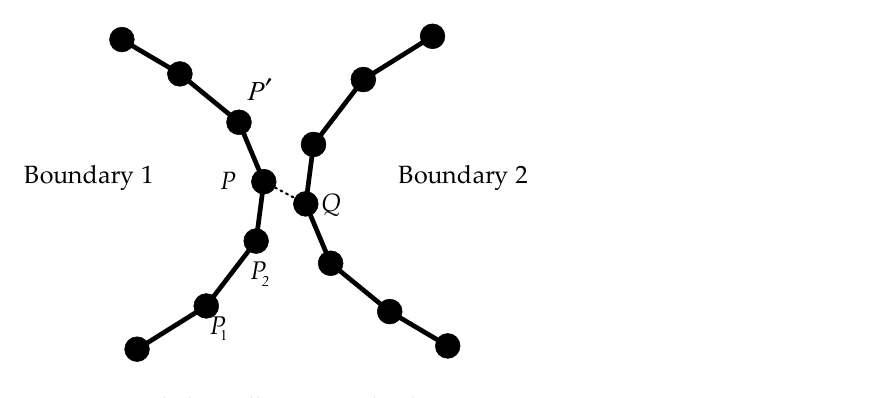
Figure 8. The virtual camera coordinate system. A.